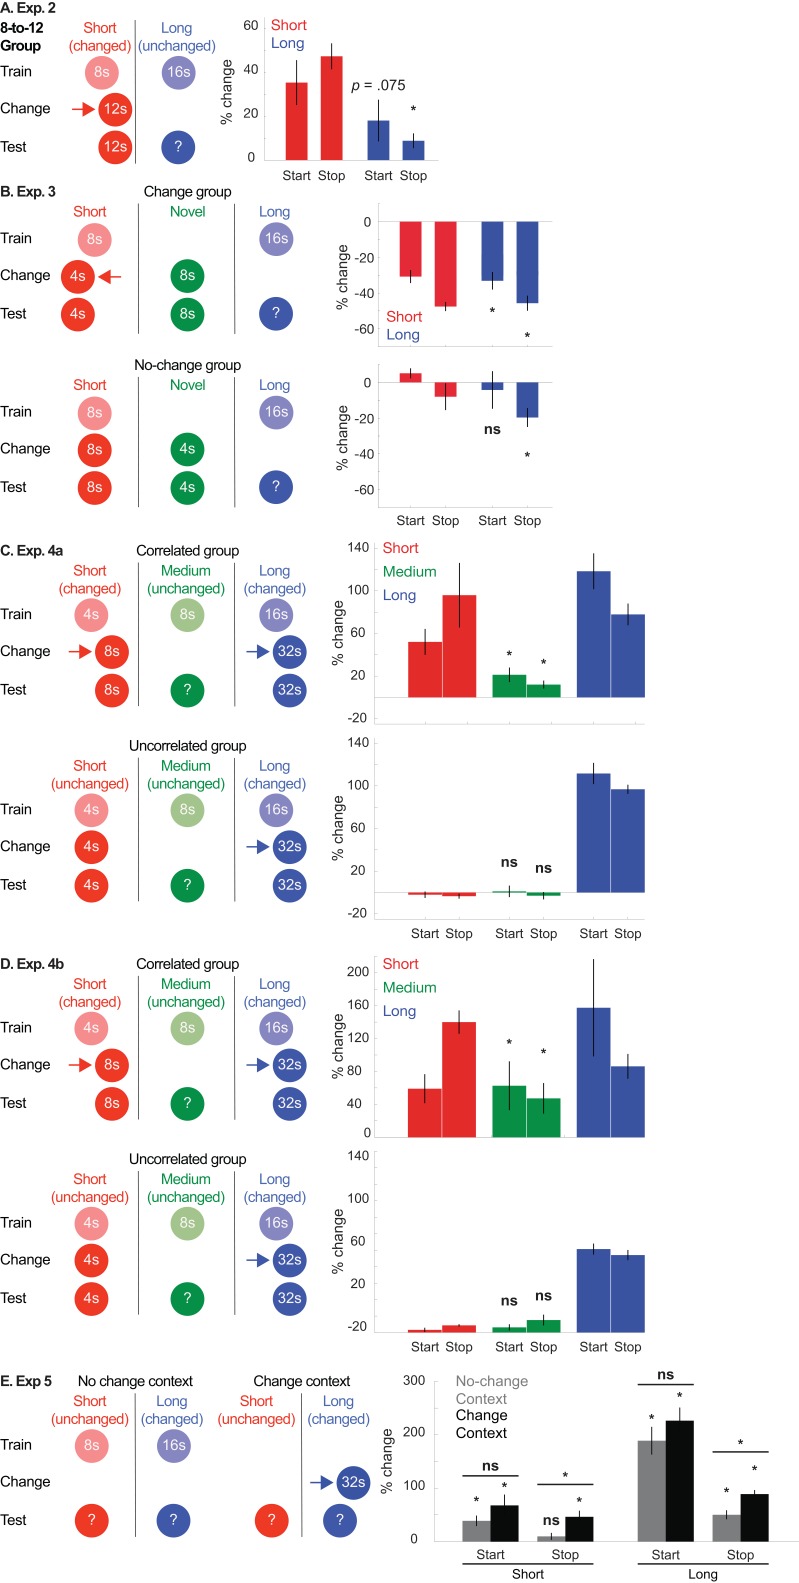
Same as Figure 1—figure supplement 2, but showing single-trial averages (±SEM) for the remainder of the groups in the experiments (A, B, C, D, and E correspond to the 8-to-12 group of Experiment 2, both groups included in Experiment 3, the two Experiment 4 groups, and Experiment 5, respectively).Three rats in Experiment 5 did not show any trials that met our criteria for being included in the single trial analysis (>2 responses and a start and stop time that occurred before and after the peak time, respectively). In those cases, they were omitted when computing the averages and statistics.10.7554/eLife.38790.008Figure 1—figure supplement 3—source data 1.Data used to generate Figure 1—figure supplement 3.